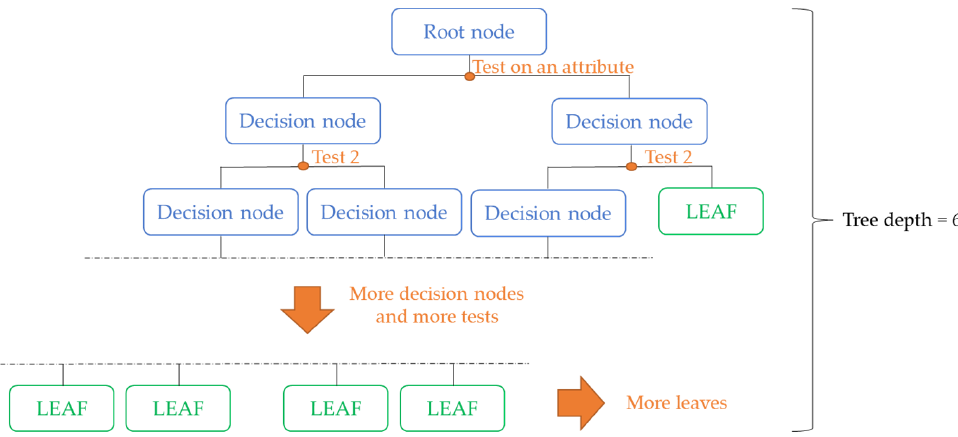
Figure 4. Schematic representation of decision tree of depth 6.